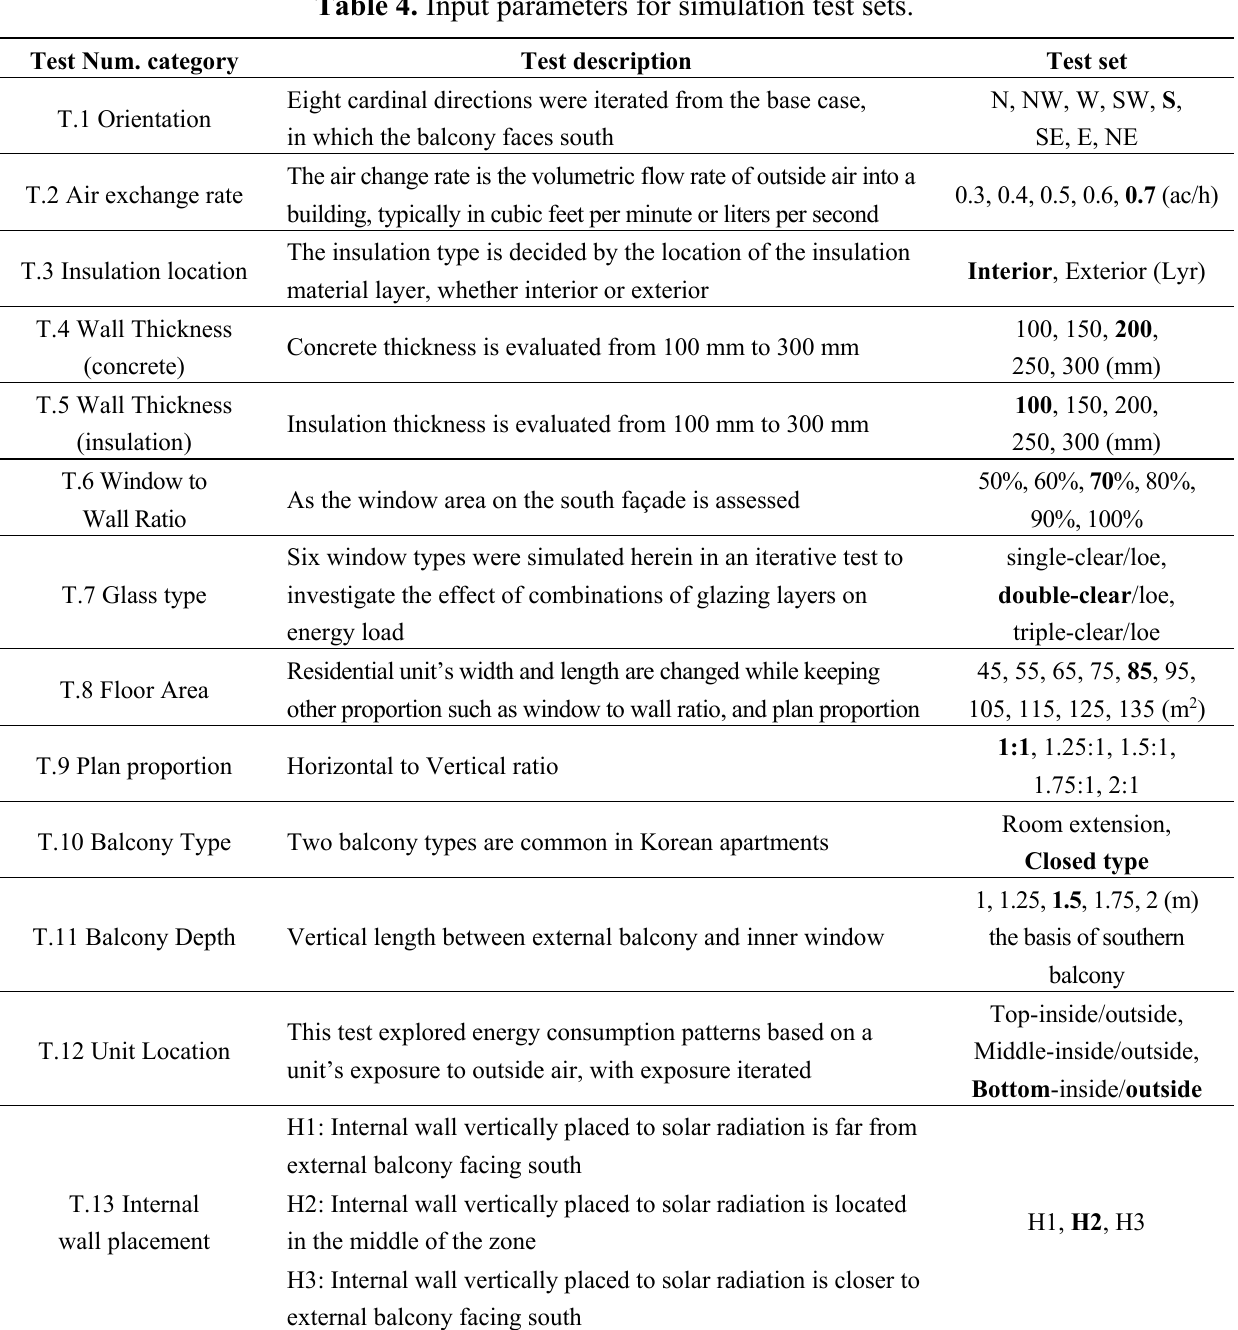
Table 4. Input parameters for simulation test